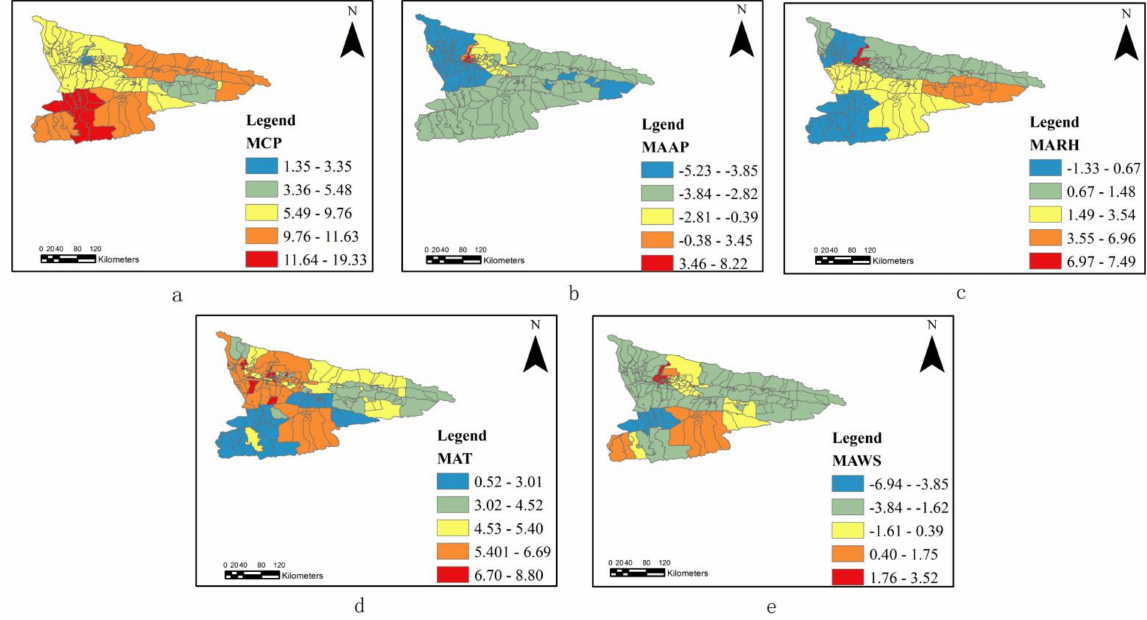
Figure 4. Spatial distribution of the coefficients for climate factors. (( a ). MCP, ( b ). MAAP, ( c ). MARH, ( d ). MAT, ( e ).